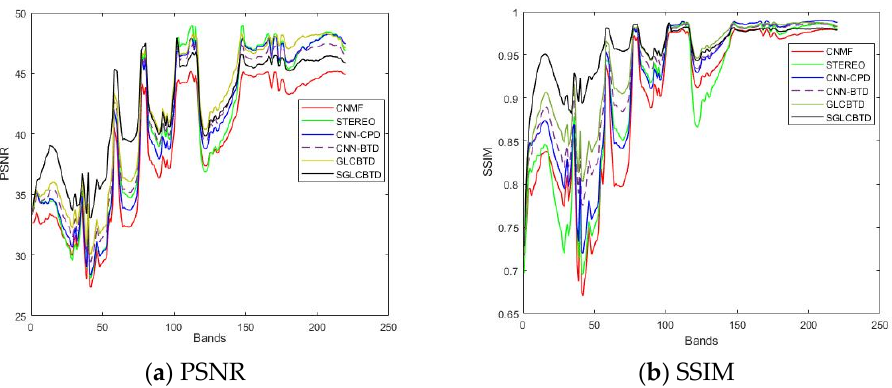
Figure 3. PSNR and SSIM in function of each band for different methods on the Indian Pines dataset. Figures 4 and 5 show the fusion results on the Indian Pines dataset in 10-th and 100-th bands, respectively. From the visual effect, it can be seen that SGLCBTD is closer to the original image with reduced red areas and increased blue areas, moreover, the edge details are clearer than those of other methods.